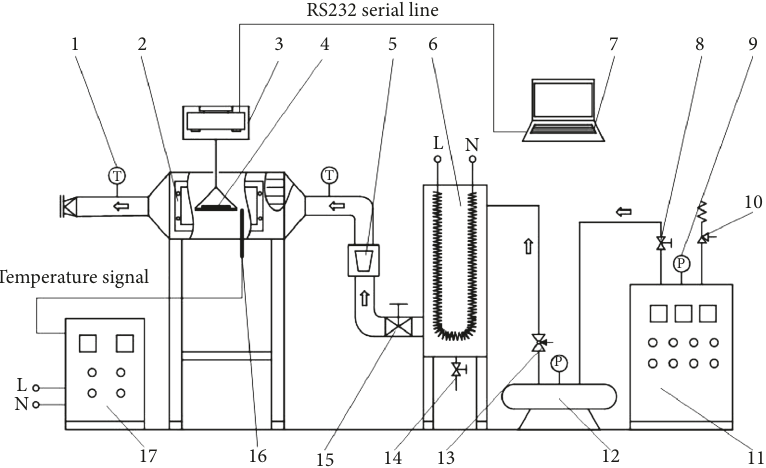
Figure 1: Schematic diagram of superheated steam drying experimental setup. (1) Thermometer. (2) Drying chamber. (3) Electronic balance. (4) Sample. (5) Metal tube rotameter. (6) Heater. (7) Computer. (8) Stop valve. (9) Pressure gauge. (10) Safety valve. (11) Steam boiler. (12) Subcylinder. (13) Throttle valve. (14) Drain valve. (15) Throttle valve. (16) Temperature sensor. (17) Control